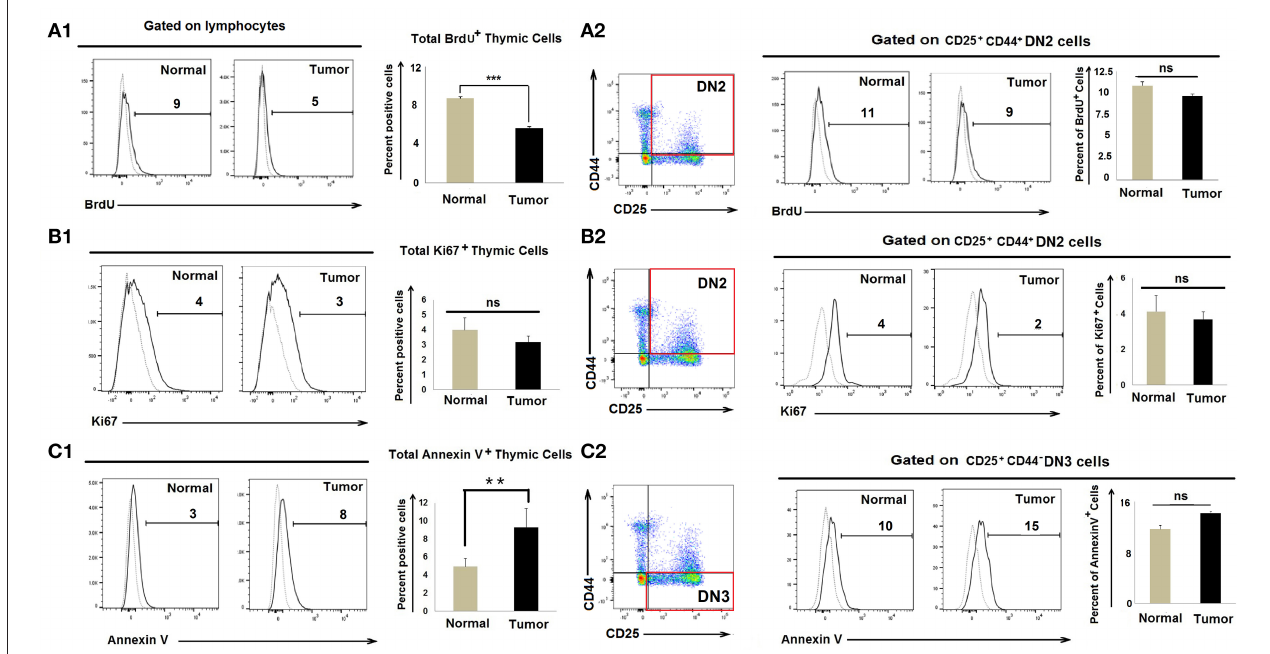
FIGURE 2 | Accumulation of DN2b T cells associated with neither proliferation nor apoptosis: Flow cytometric analysis as presented by histograms and bar diagrams of total BrdU (A1) , Ki67 + (B1) , and AnnexinV + (C1) cells from thymi of normal and tumor-bearing mice. Dotted line represents isotype control. Similar analysis